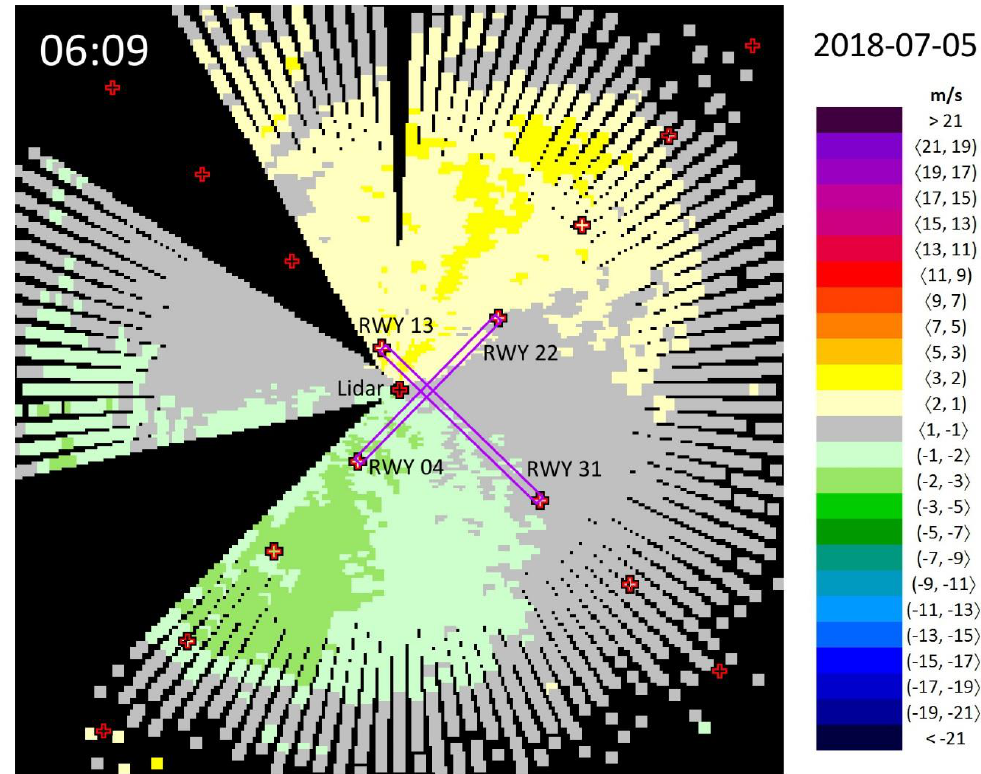
Figure 3. Wind field observed by the Doppler lidar (located at the center of the figure) at the Bratislava Airport at 06:09 UTC on 5 July 2018. Wind blowing towards the lidar is defined as positive. Runways (abbr. RWY) are indicated by the purple color.